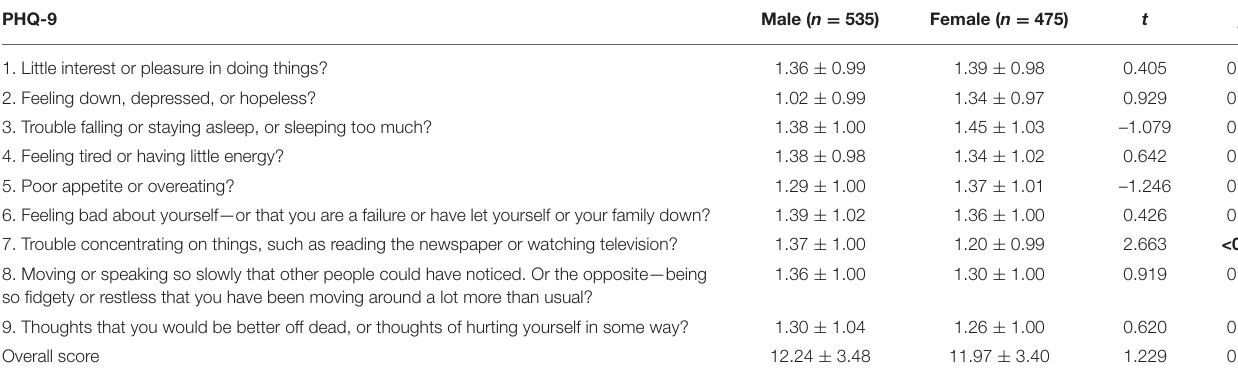
TABLE A1 | Gender difference in PHQ-9 item scores ( ¯ x ± s ). PHQ-9